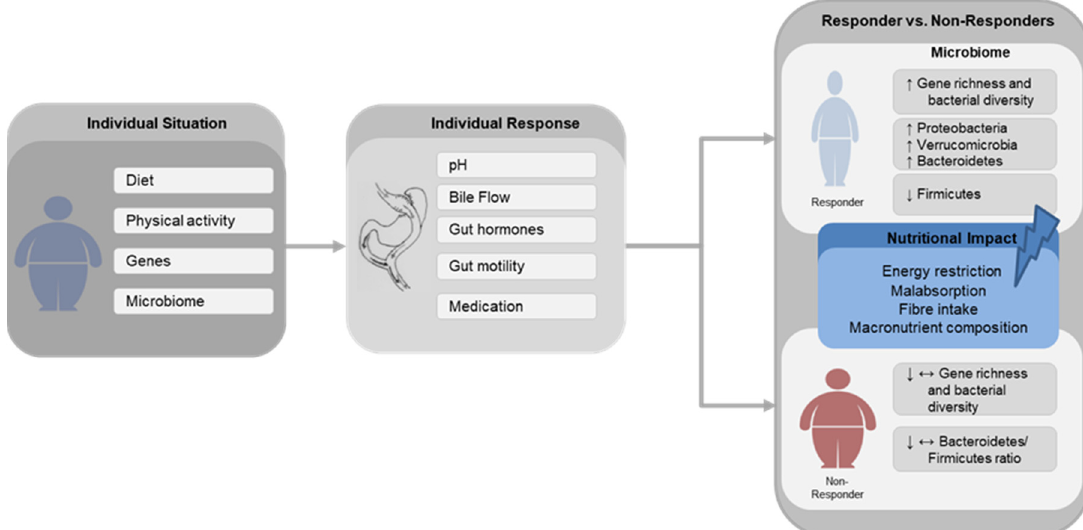
Figure 1. Schematic Illustration Schematic illustration of the main gut microbial changes associated with successful (Responder) and poor (Non-Responder) weight loss after gastric bypass surgery and the possible impact of nutritional factors. Diet, physical activity, genes and gut microbiome composition are widely described factors leading to obesity. Following gastric bypass surgery, the individual response is affected by alterations in pH, bile flow, changes in gut hormones secretion, gut motility and medication usage. ↑ —increase, ↓ —decrease, ↔ —unchanged.